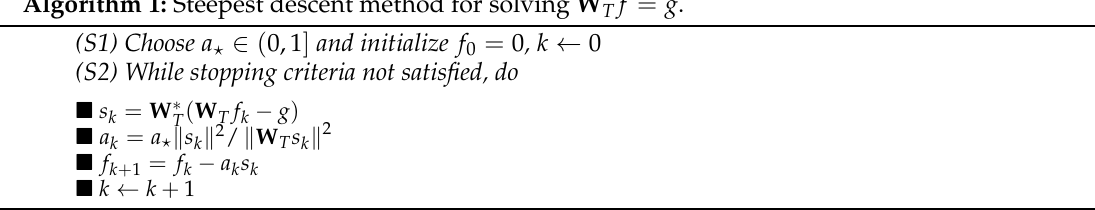
Algorithm 1: Steepest descent method for solving W T f = g